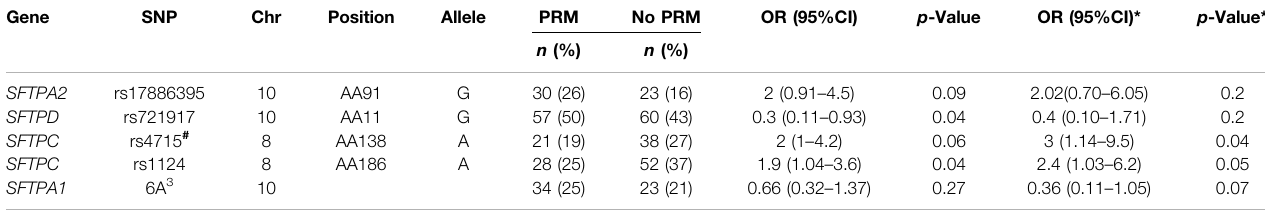
TABLE 2 | Persistent respiratory morbidity (PRM) vs. no PRM at 12 months (univariate analysis).